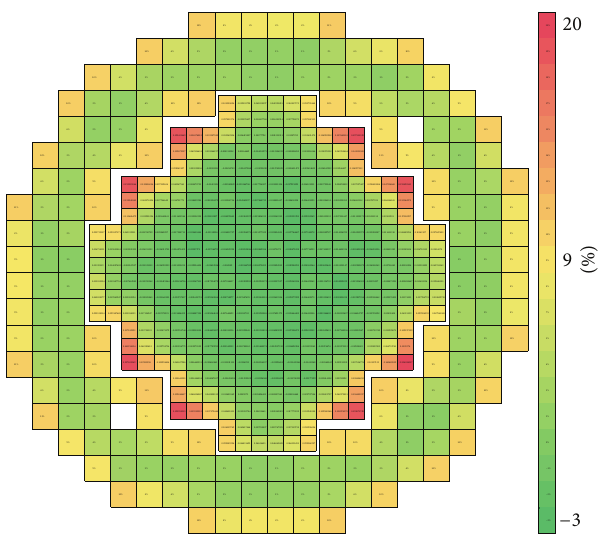
of the core is within 3% with respect to Serpent 2. From safety rod will be most likely located in this area.